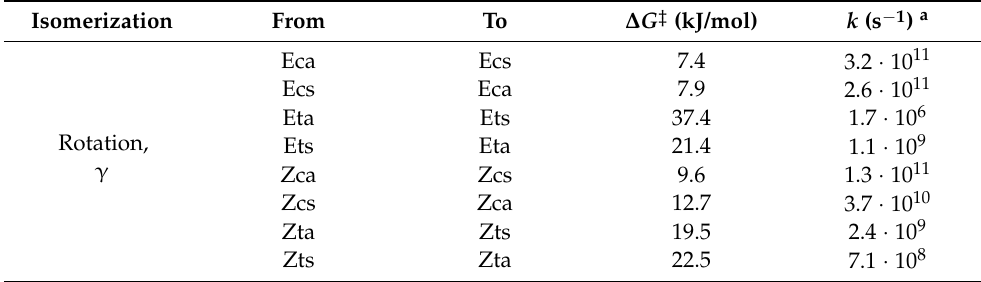
grouped with respect to the interconversion